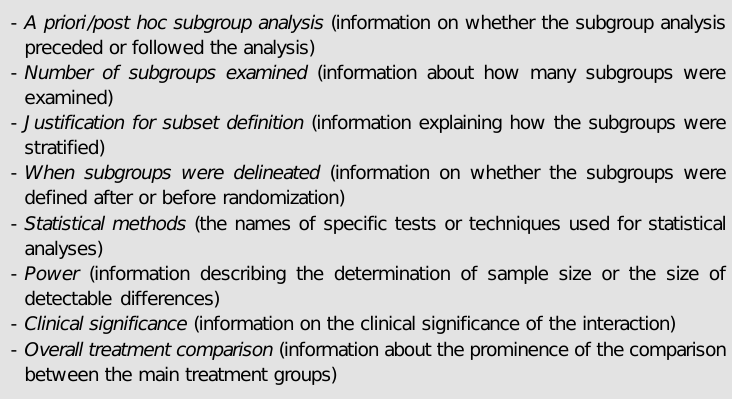
Table 1. List of important methodological items when reporting subgroup analysis in randomized clinical trials. - A priori/post hoc subgroup analysis (information on whether the subgroup analysis preceded or followed the analysis) - Number of subgroups examined (information about how many subgroups were examined) - Justification for subset definition (information explaining how the subgroups were